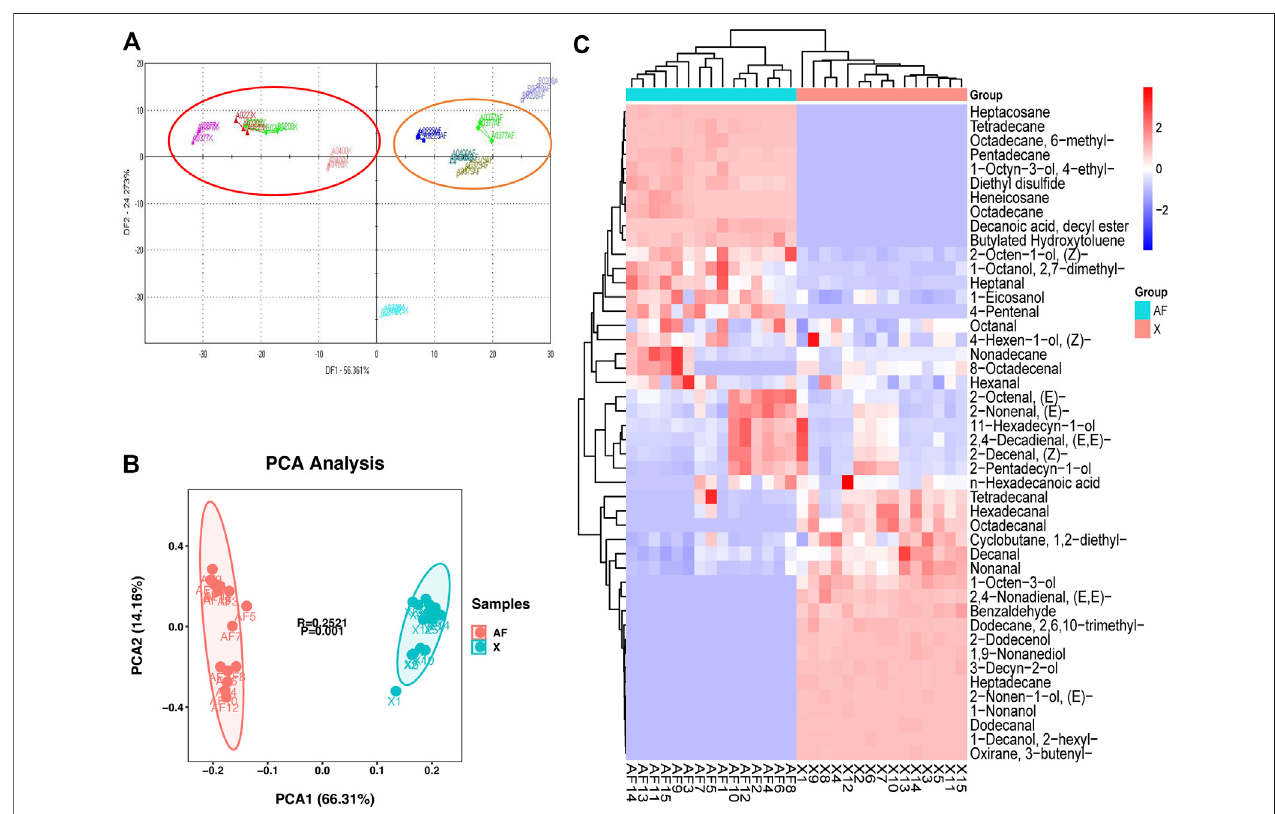
FIGURE 1 | (A) Discriminant factor analysis (DFA) of E-nose results for different tissues in WC chickens. (B) PCA of BM and AF individuals. (C) Cluster diagram of volatile compounds.